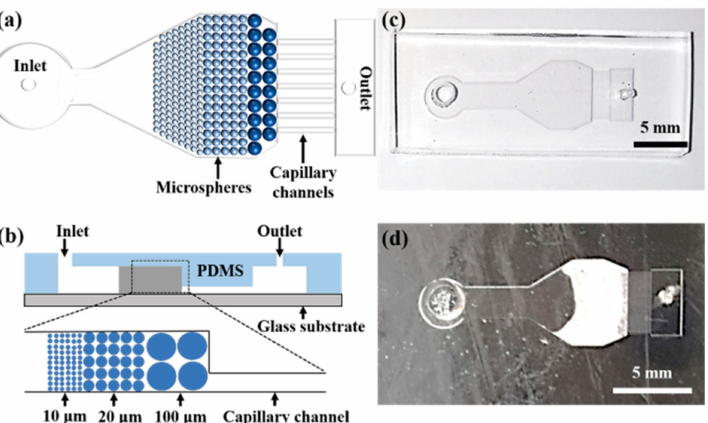
Figure 1. Schematic illustrations of the microfluidic chip of ( a ) the top view and ( b ) the cross section, and photos of the microchip ( c ) before and ( d ) after stacking